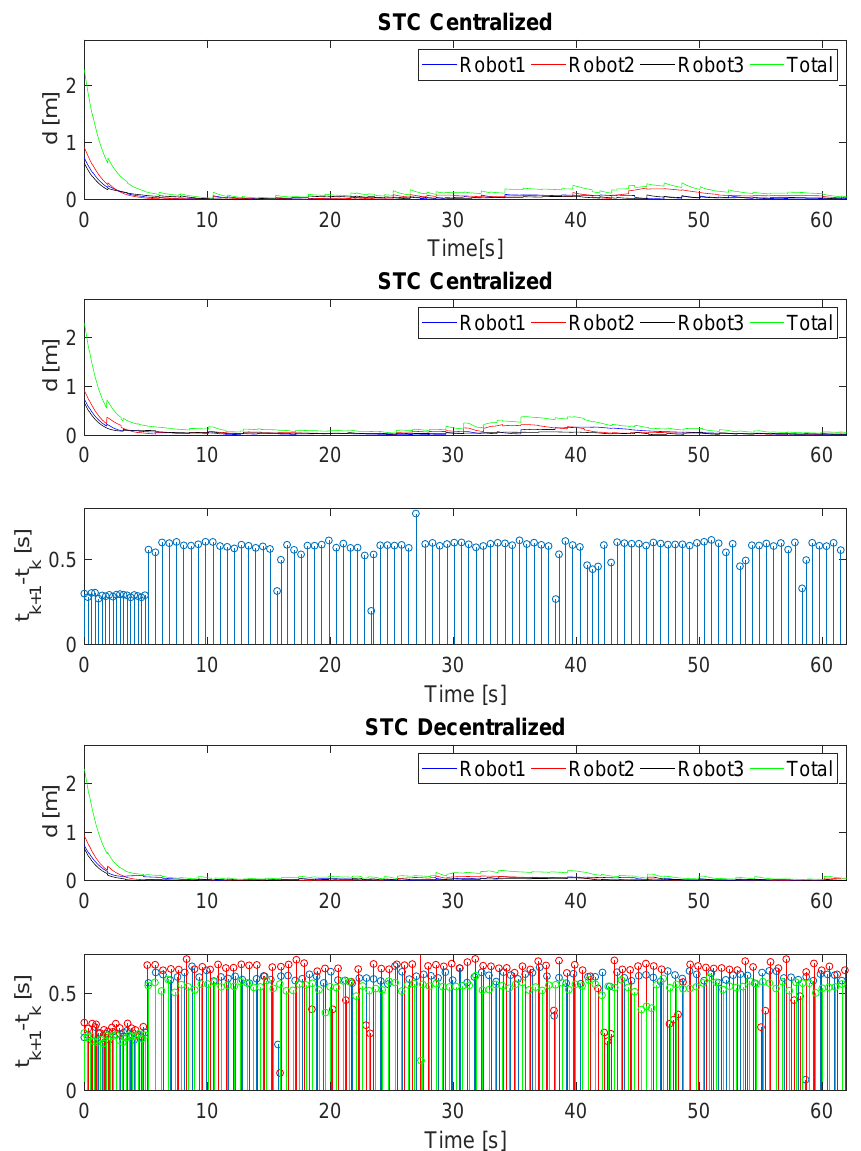
Figure 12. Lyapunov function of the formation and inter-execution times for STC strategies. Robot 1 is represented in blue, Robot 2 in red, Robot 3 in black and the Formation in green. The top figure represents the periodic implementation, the middle one the STC with centralized triggering (26) and the bottom the STC with decentralized triggering